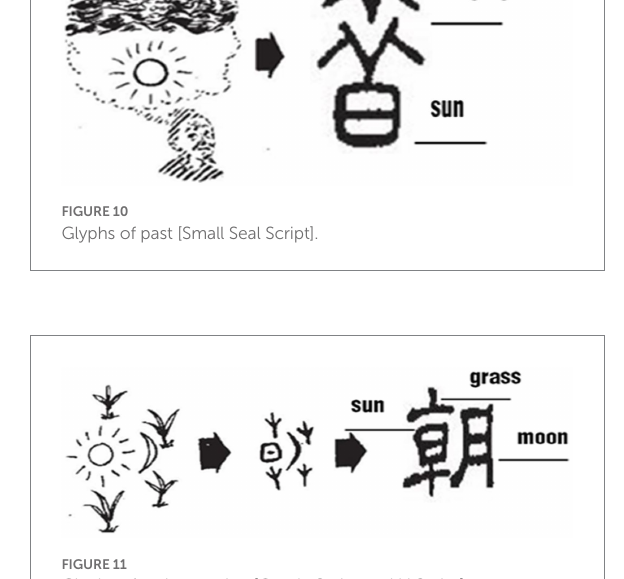
FIGURE 11 Glyphs of early morning [Oracle Script and Li Script].